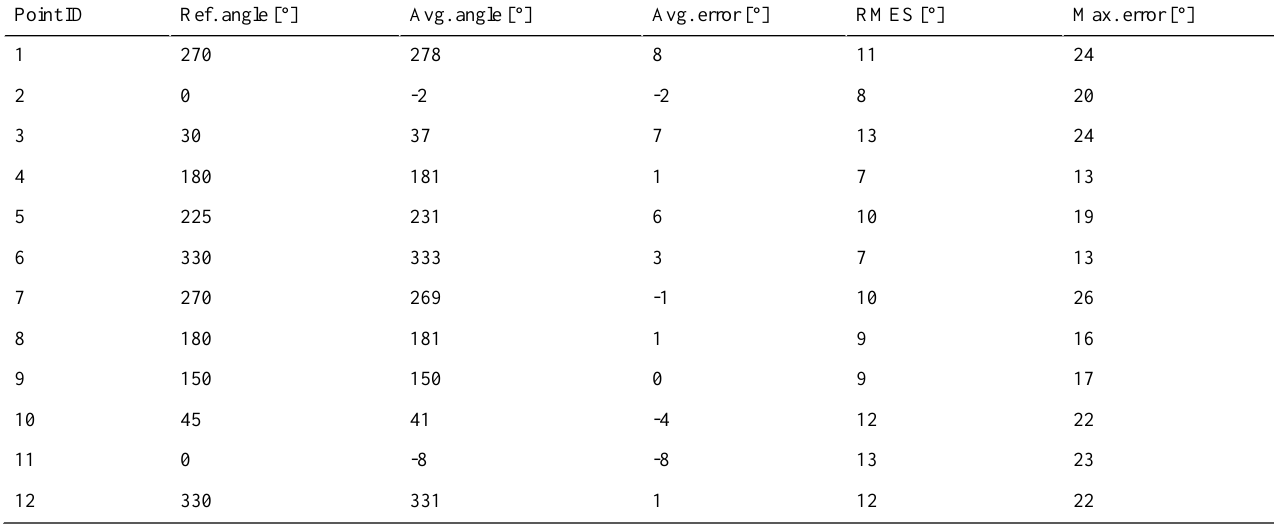
Table 2. Statistical results aggregated per marker point for person orientation estimation method using AOE algorithm (Method1) with the smartphone on the hip